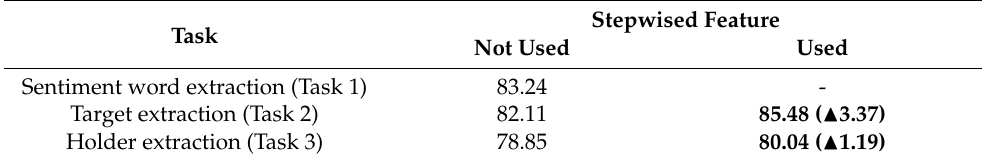
Table 2. Performance evaluation in accuracy for stepwised features of each task.